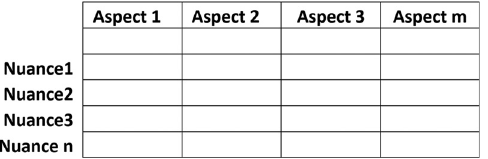
Figure 2. An n (cid:3) m matrix showing how aspects relate to nuances. An aspect here is a component of any attack model of interest to better understand its